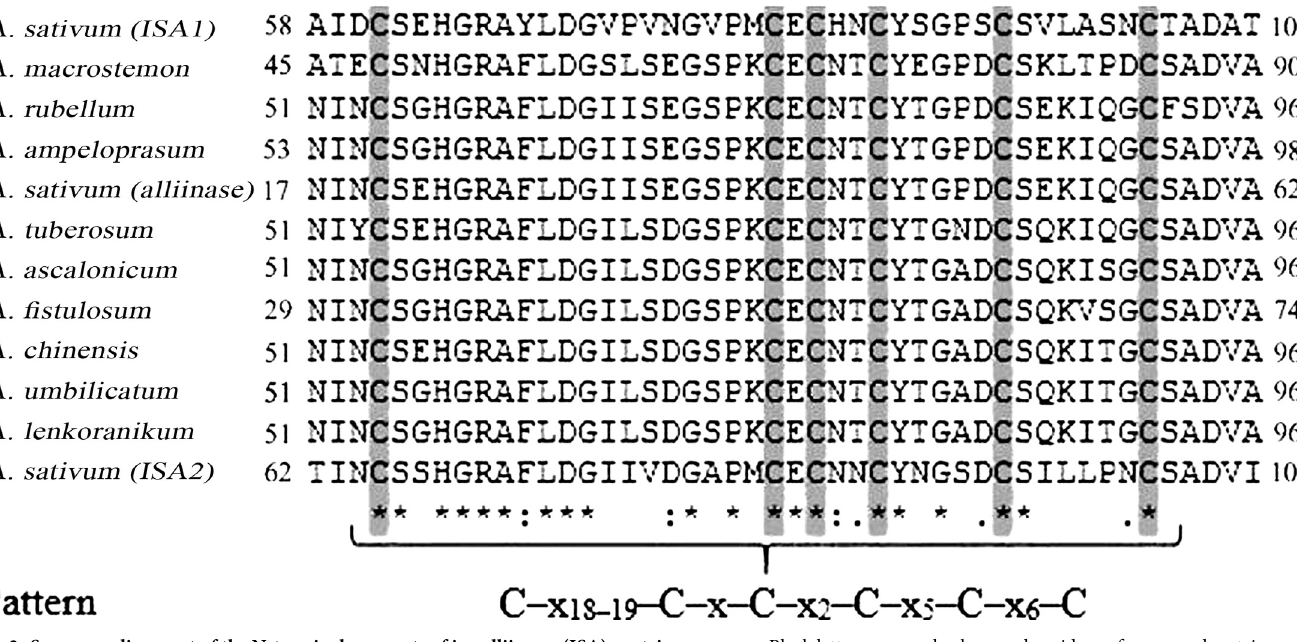
PLOS ONE | https://doi.org/10.1371/journal.pone.0228747 February 24,